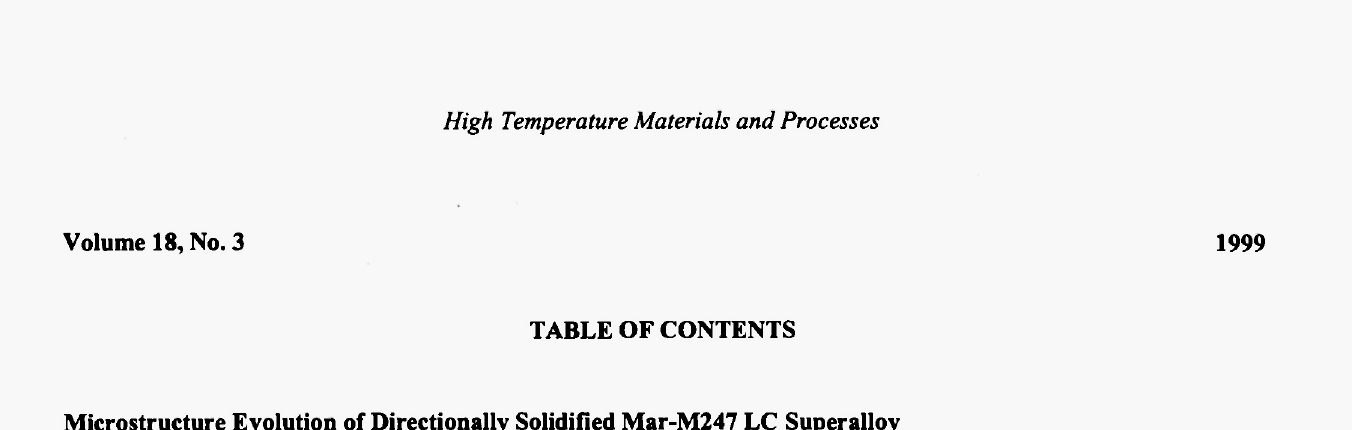
Microstructure Evolution of Directionally Solidified Mar-M247 LC Superalloy and Its Dependence on Solidification